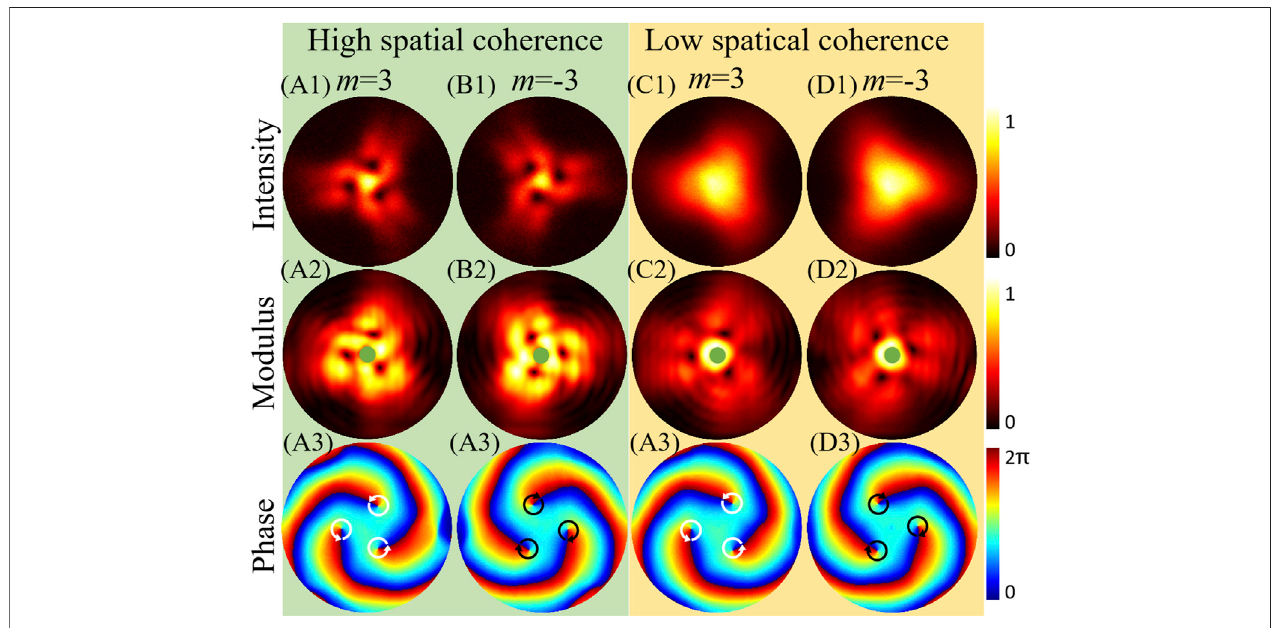
FIGURE12| Experimental intensityonCCD 1 andCSDdistributionsofthePC-PEPVbeamwithoddpowerorder n (cid:1) 3andpositiveandnegativeTCsunderhigh( σ (cid:1) 20 mm) and low spatial coherence width ( σ (cid:1) 0.5 mm). (A1 – D1) are intensity patterns, (A2 – D2) are modulus of the CSD function, and (A3 – D3) are phase patterns of the CSD